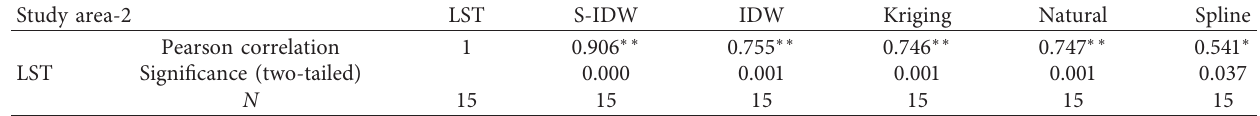
Table 20: Correlation analysis of interpolation results of 5 kinds of interpolation methods on Jul. 10, 2013. Study